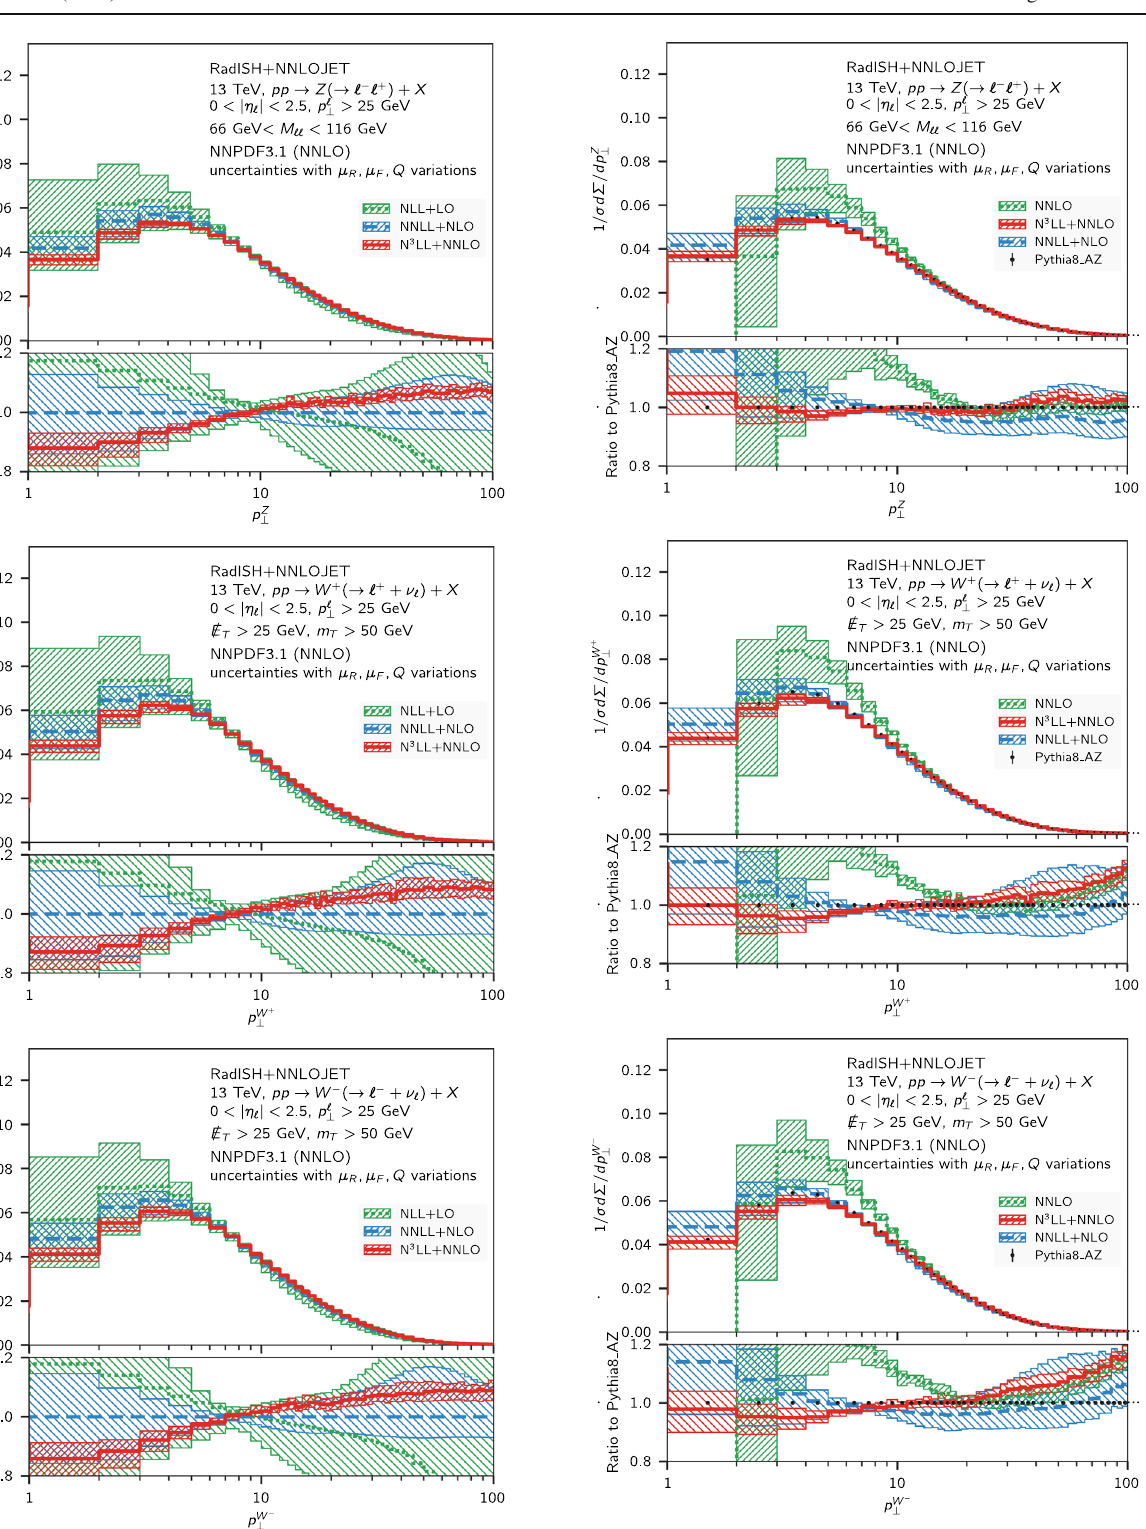
Fig. 2 Comparison of the normalised transverse momentum distribu- tionforneutralandchargedDrell–YanpairproductionatNNLO(green, dotted), NNLL+NLO (blue, dashed) and N 3 LL+NNLO (red, solid) at √ s = 13 TeV for the fiducial volume defined in the text. For reference, the Pythia8 prediction in the AZ tune is also shown, and the lower panel shows the ratio of each prediction to the Pythia8